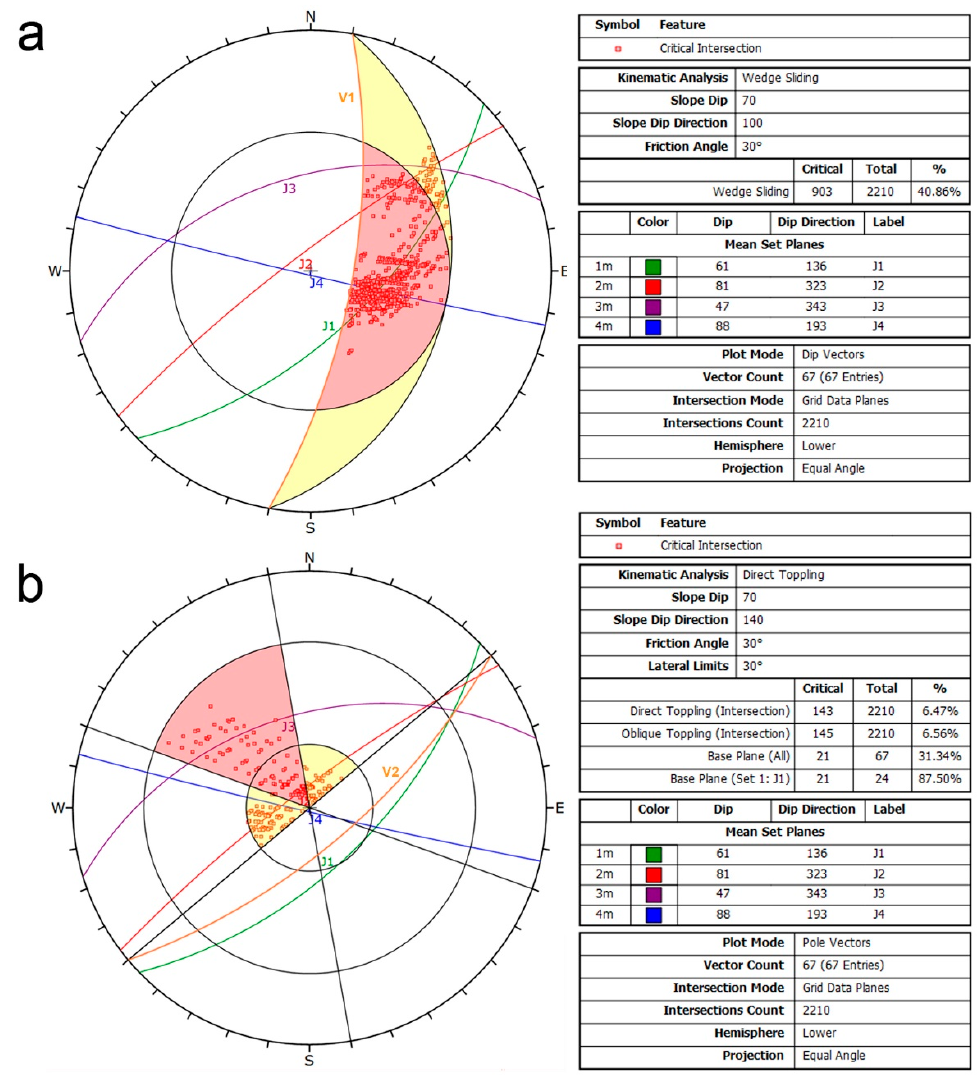
Figure 6. Examples of kinematic analysis for wedge sliding along V1 ( a ) and direct toppling along V2 ( b ). Table 3. Results of the kinematic stability analysis along four identified slopes.